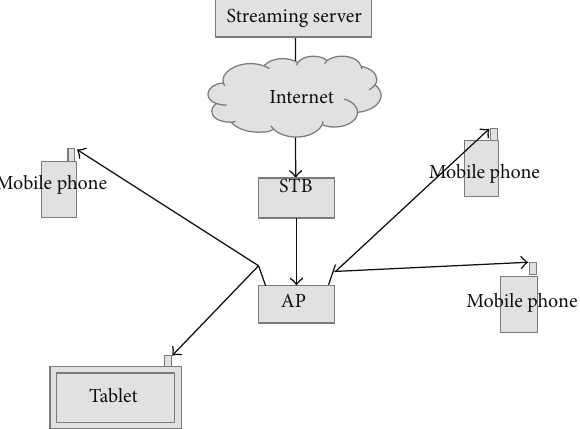
Figure 1: Diagram of scalable streaming in a wireless